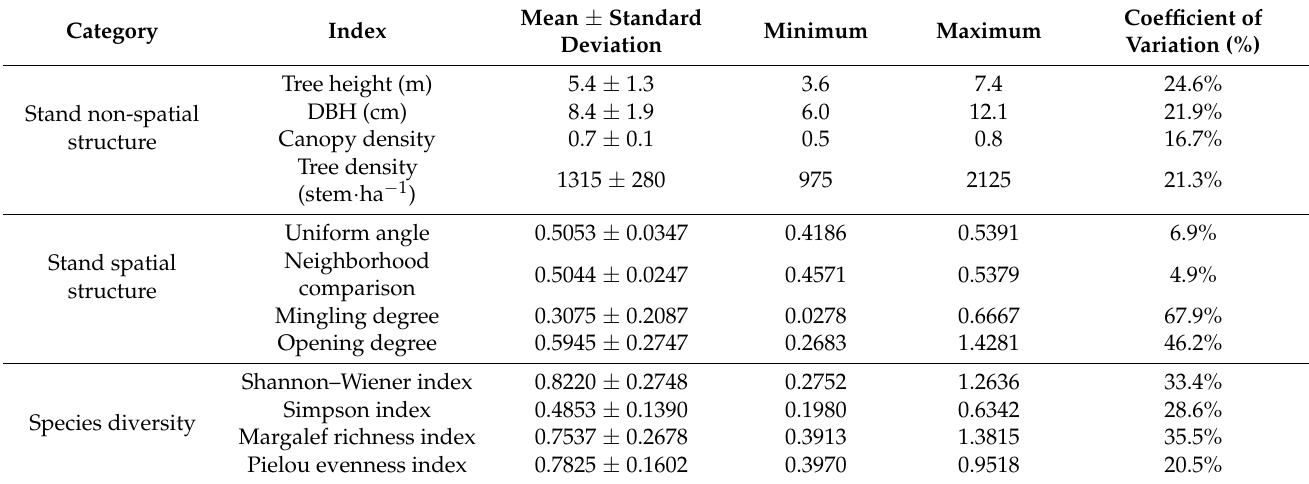
Table 2. Basic information of stand structure and species diversity index of the sampling